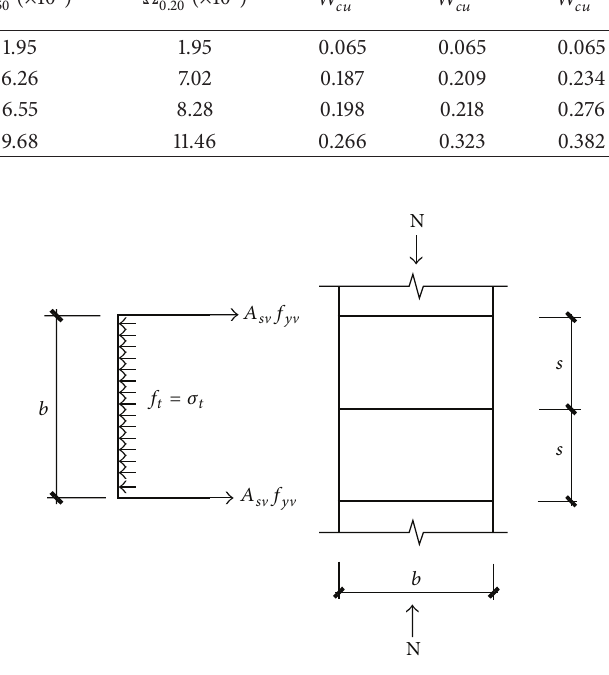
Figure 8: The equivalent of fiber bridging force and stirrup binding